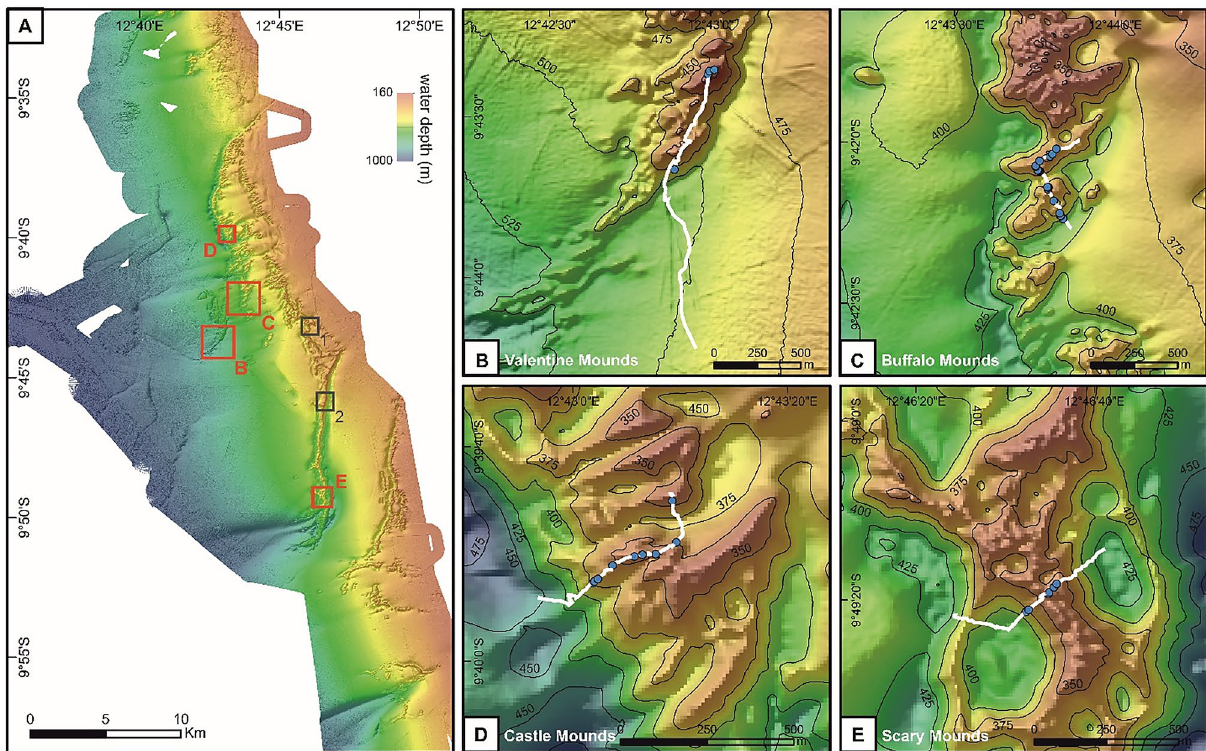
Figure 2. Occurrence of Madrepora oculata on the Angolan cold-water coral mounds. ( A ) Overview map of the Angolan coral mound province. Coral mounds for which ROV video footage was analysed are marked by boxes. Grey boxes indicate Snake mound (1) and Anna ridge (2), for which no Madrepora records have been documented; red boxes indicate the Valentine (B) , Buffalo (C) , Castle (D) and Scary (E) mounds being colonised by M. oculata . ( B–E ) Detailed maps of the Valentine, Buffalo, Castle and Scary coral mounds. ROV video transects (white line) crossing the respective mounds and identified locations of living M. oculata (blue dots) are indicated. Bathymetry data was acquired during R/V Meteror cruise M122 (Raw data is available under https:// www2. bsh. de/ daten/ DOD/ Bathy metrie/ Sueda tlant ik/ m122. htm).